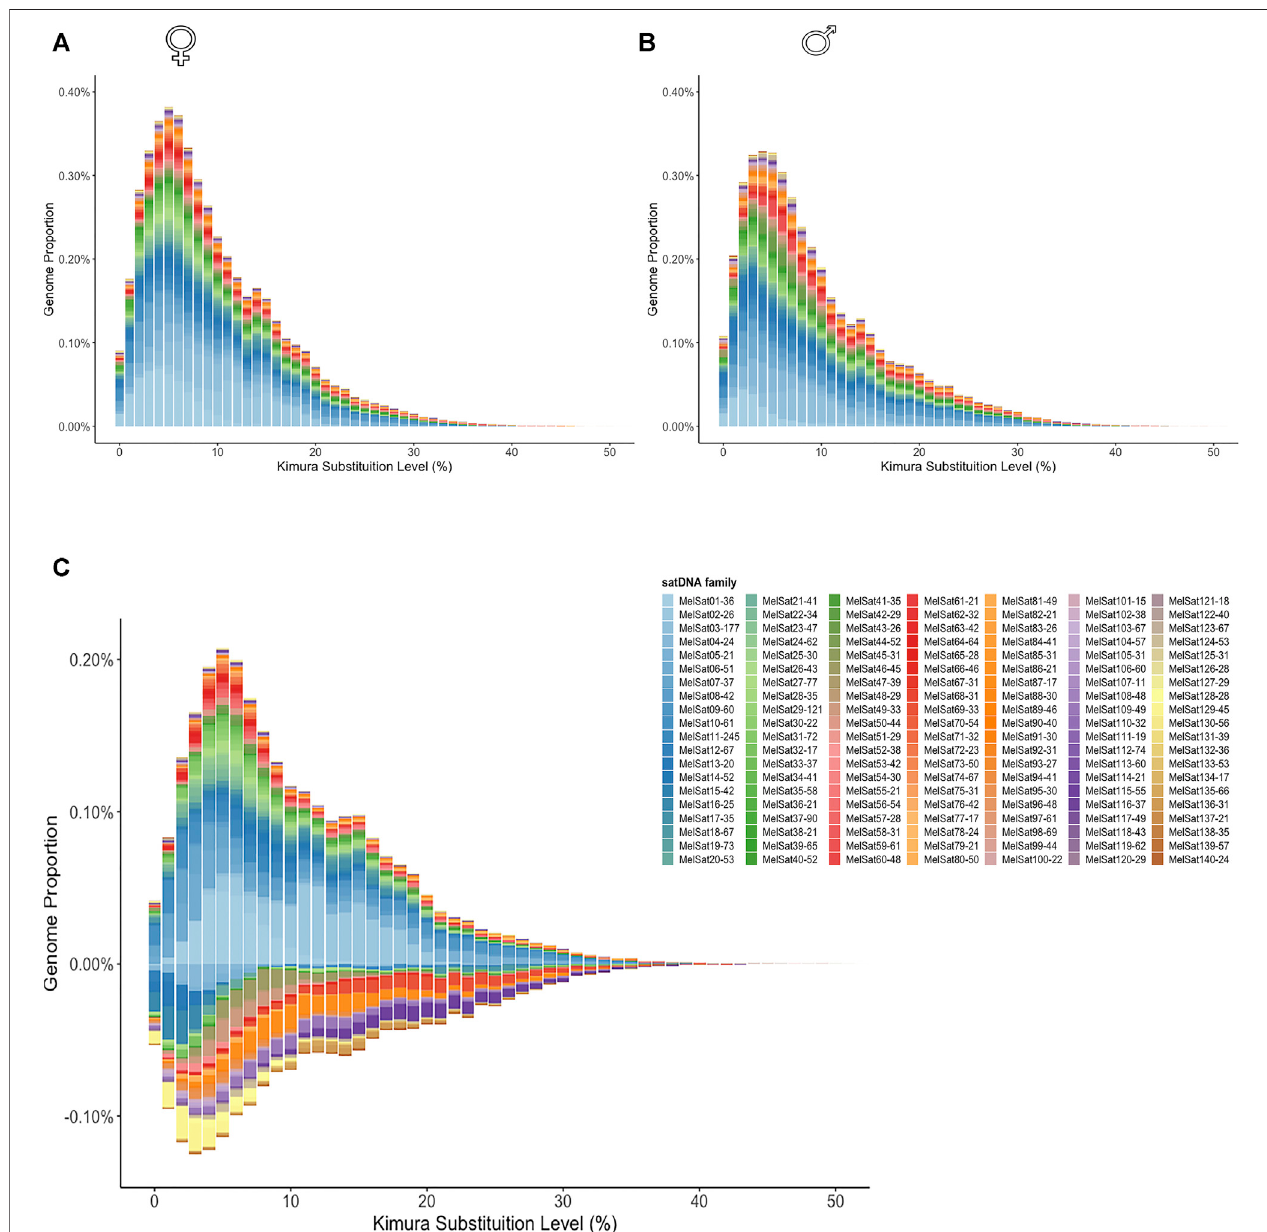
FIGURE1| Repeatlandscapes(abundancevs.divergence)forsatDNAsidenti fi edinfemale (A) andmale (B) M.elongatus .Thegraphsshow,foreachcolor-coded element, the sequence divergence according to Kimura distance (x-axis) in relation to their copies in the genome (y-axis). Copies clustered to the left (lower divergence) potentiallycorrespondto recent copies occurringin the genome. A subtractive landscape (C) was obtained by subtracting male library (negative values) from the female one (positive values). Notice the diversity of satDNA families also present in the male genome in the subtractive landscape.